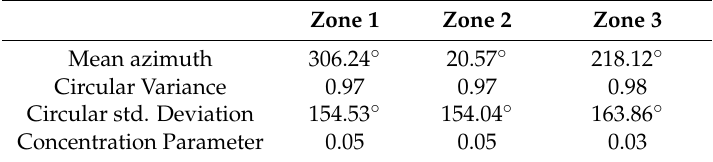
Table 3. Circular statistics for the values of the orientation for the three studied zones.